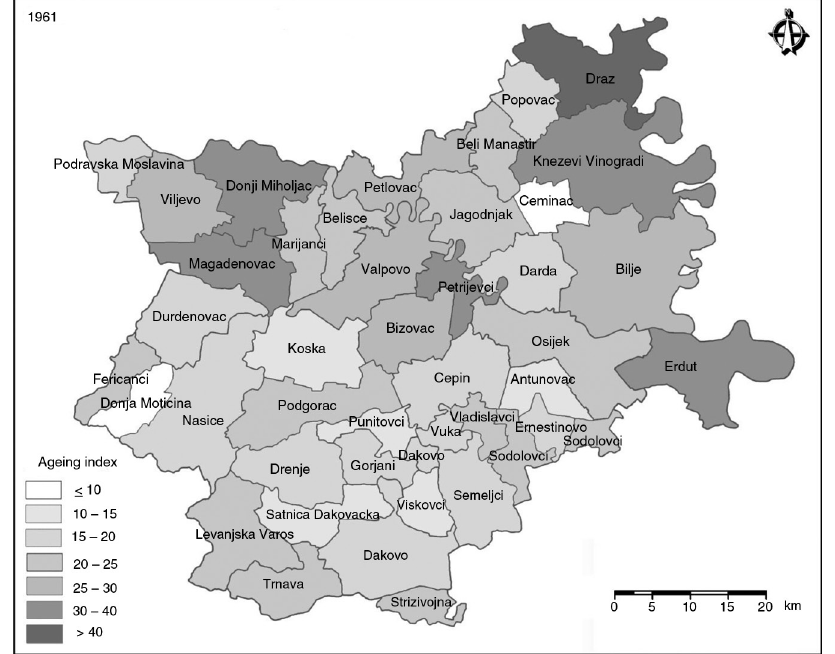
Figure 3. Ageing index of the municipalities in 1961. Source : CBS